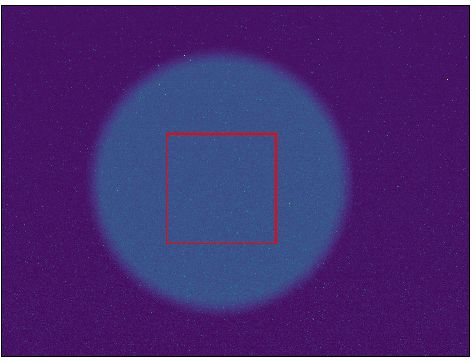
Figure 1. Example region of interest (red rectangle) from relative spectral response data set. Pixels from center of sphere (exit port of mini integrating sphere) were averaged for every image captured. This was accomplished for all 250 images captured (400 nm–900 nm, 2 nm step size) for all bands.